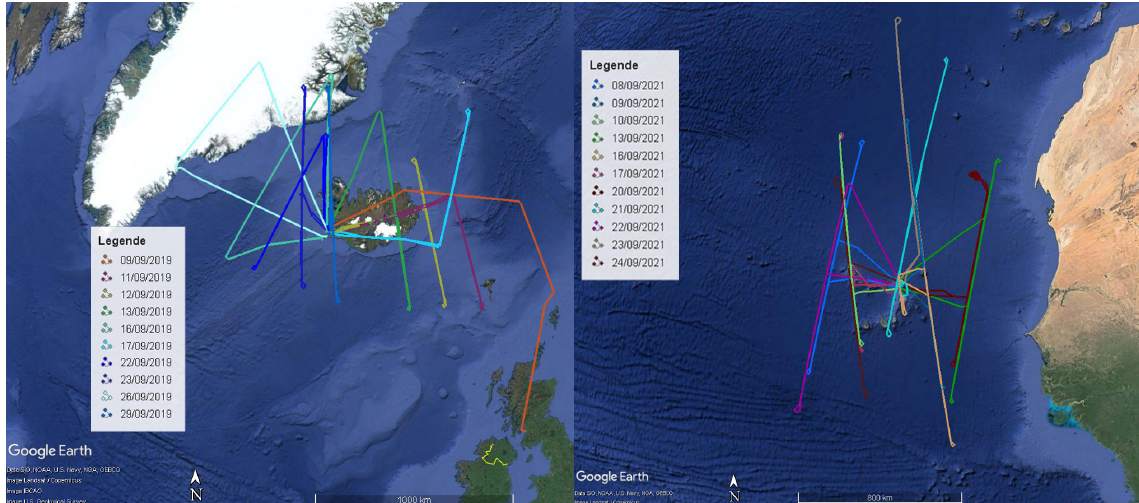
Figure 1. Flight tracks of the Falcon aircraft during the AVATAR-I campaign (left) and the AVATAR-T campaign (right). Each color repre- sents a single flight. Table 2. Overview of Aeolus underflights performed during the AVATAR-I and the AVATAR-T campaigns. Falcon flight Aeolus underflight # for